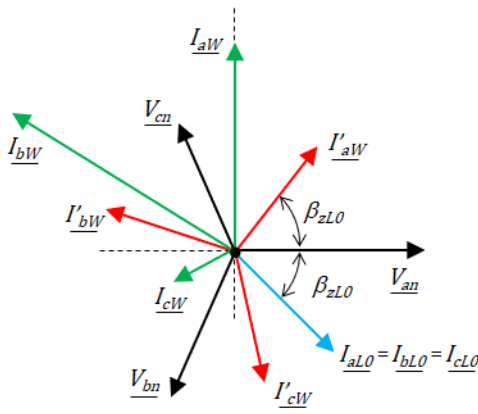
Figure 6. Joint vector diagram of phases A, B and C.